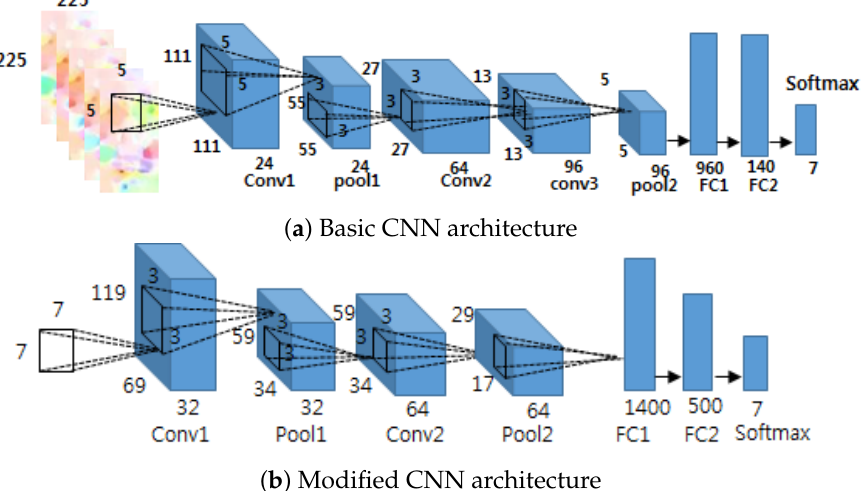
Figure 4. Basic and modified CNN architectures for facial expression recognition from facial mo- tion